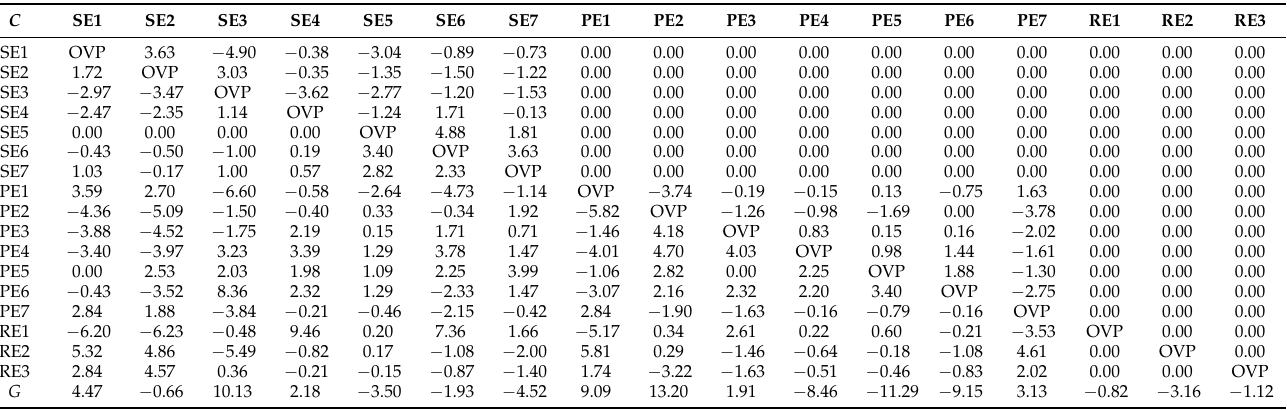
Table 8. Cross-impact